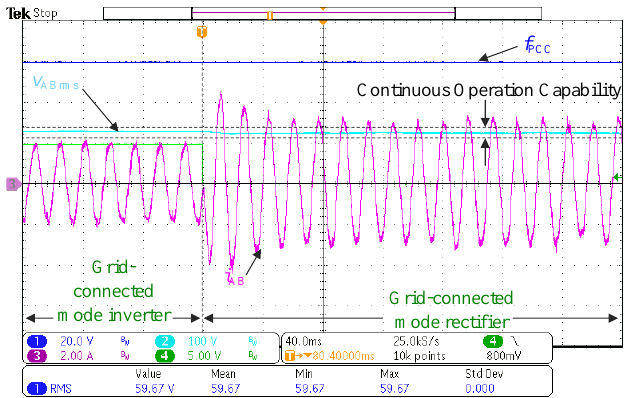
Figure 19. The transition of the current from grid-connected mode as inverter to grid-connected mode as